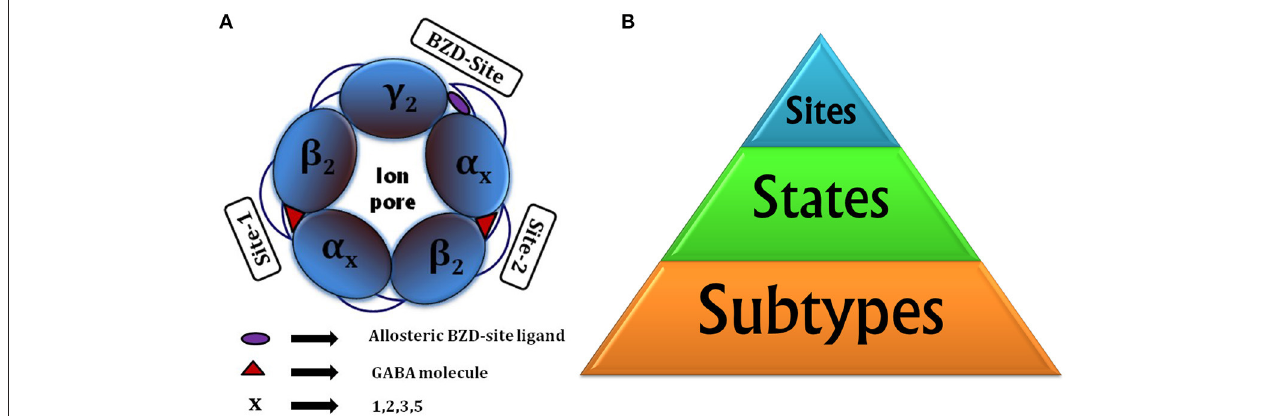
FIGURE 1 | (A) Animated top view of GABA A -R showing (i) The subunit arrangement and channel pore; (ii) Location of orthosteric site-2 and site-1 with bound GABA having capped C-loop; (iii) allosteric BZD-site. (B) Drug designing hierarchy: The major consideration is subtypes to target, next come the “states” of receptor it brings responsibility of finding functionally important sites or hidden allosteric sites from the ensemble of conformations, and finally the sites to be targeted, whether orthosteric or